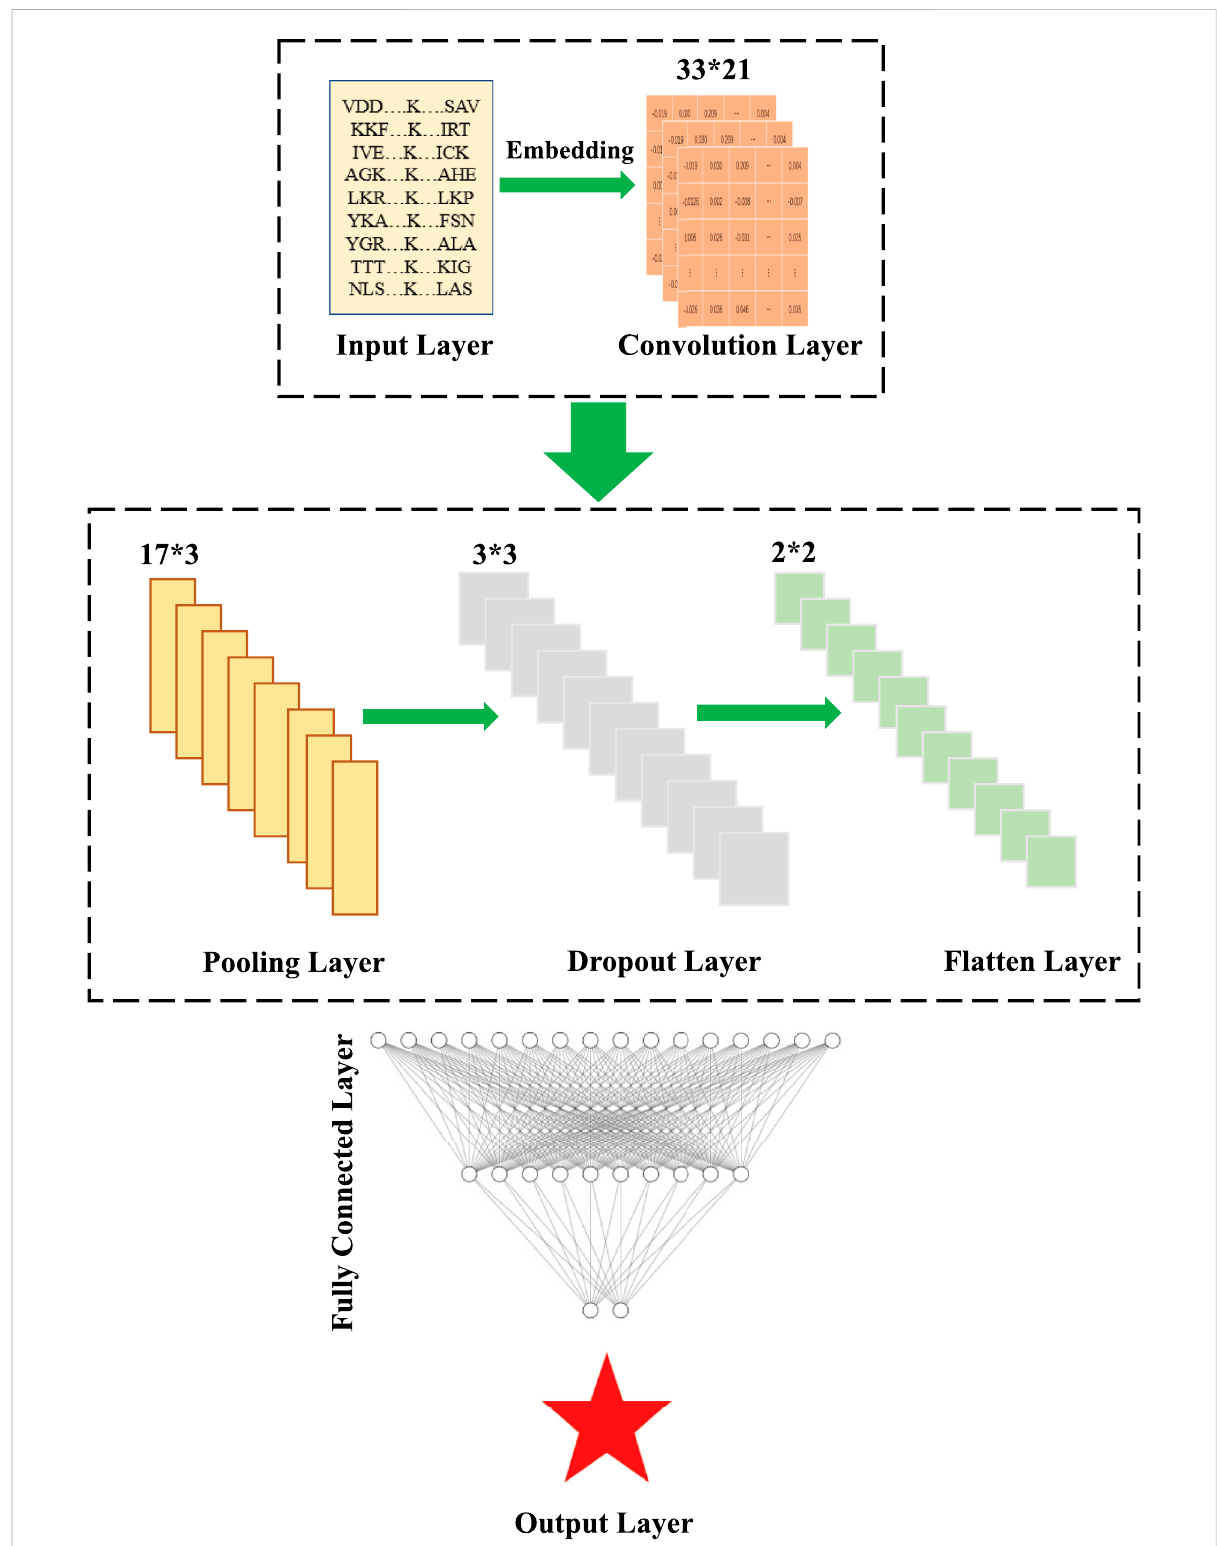
FIGURE 3 Schematicillustrationofthearchitectureofthe2D-CNN, which containsanInputLayer, aConvolutionLayer, aPoolingLayer,aDropoutLayer, a Flatten Layer, a Fully-Connected Layer, and an Output